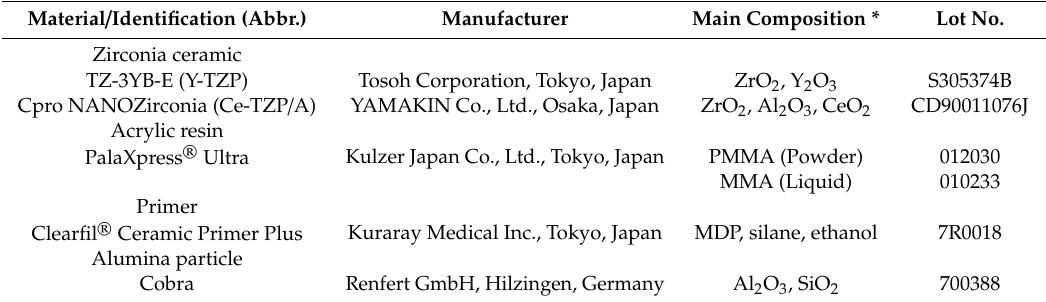
Table 1. List and composition of the materials used.